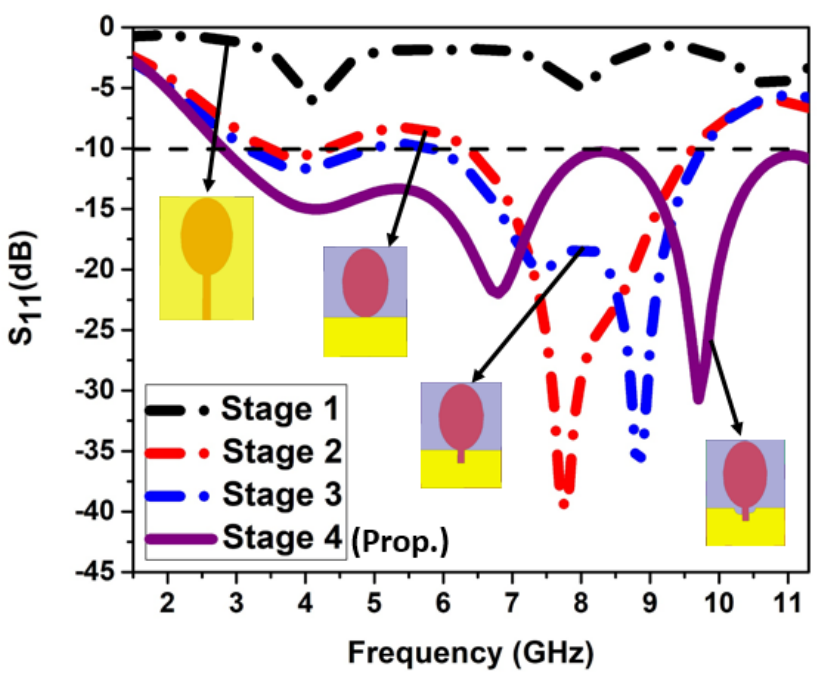
Figure 2. S 11 characteristics of UWB antenna.